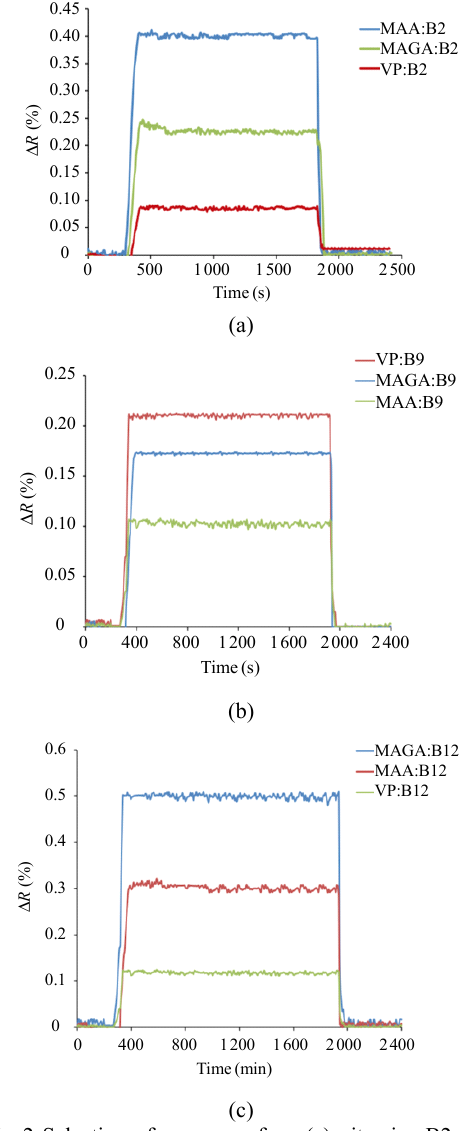
Fig. 2 Selection of monomer for (a) vitamins B2, (b) B9, and (c) B12 imprinted SPR sensors ( C vitamin B2 : 0.01 ng/mL, C vitamin B9 : 1.0 ng/mL, and C vitamin B12 : 0.1 ng/mL in all